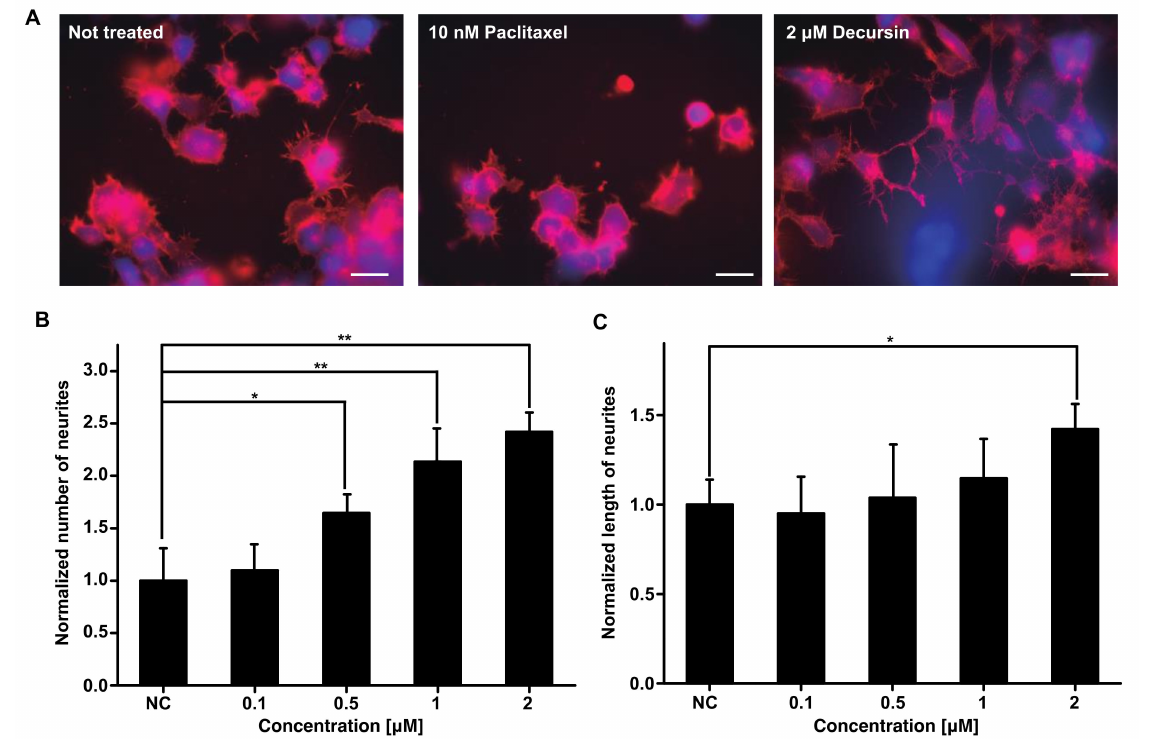
Figure 2. Number and length of F11 neurites in the presence of paclitaxel by decursin treatment. ( A ) The left, middle, and right images represent non-treatment, treatment with 10 nM of paclitaxel, and decursin treatment, respectively. The white bar represents 10 µ m. ( B ) The effect of decursin on the number of neurites in F11 cells. ( C ) The effect of decursin on the length of F11 neurites. NC: Negative control, treated with DMSO only. The number and length of F11 neurites shown in the graphs were determined from 10 images in each case, which were averaged. The number and length of F11 cells were normalized according to the F11 cells treated by DMSO only (NC), because the number and length of F11 cells treated by paclitaxel were extremely reduced, as seen in the middle panel of (A). * p < 0.05 and ** p < 0.01, determined using Student’s t -tests. This experiment was conducted in